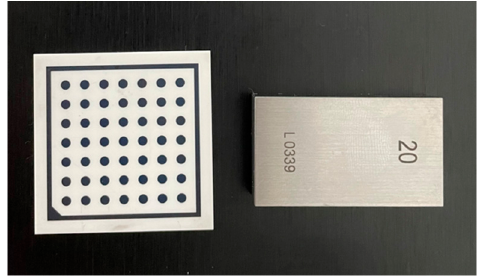
Figure 7. Calibration board and gauge blocks.